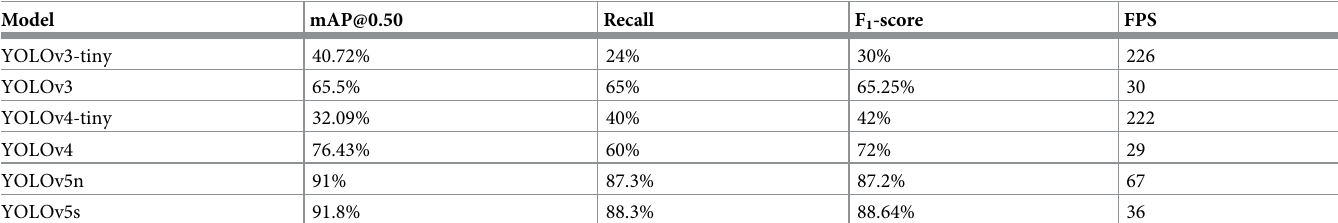
Table 5. YOLO algorithms performance for tobacco crop detection.